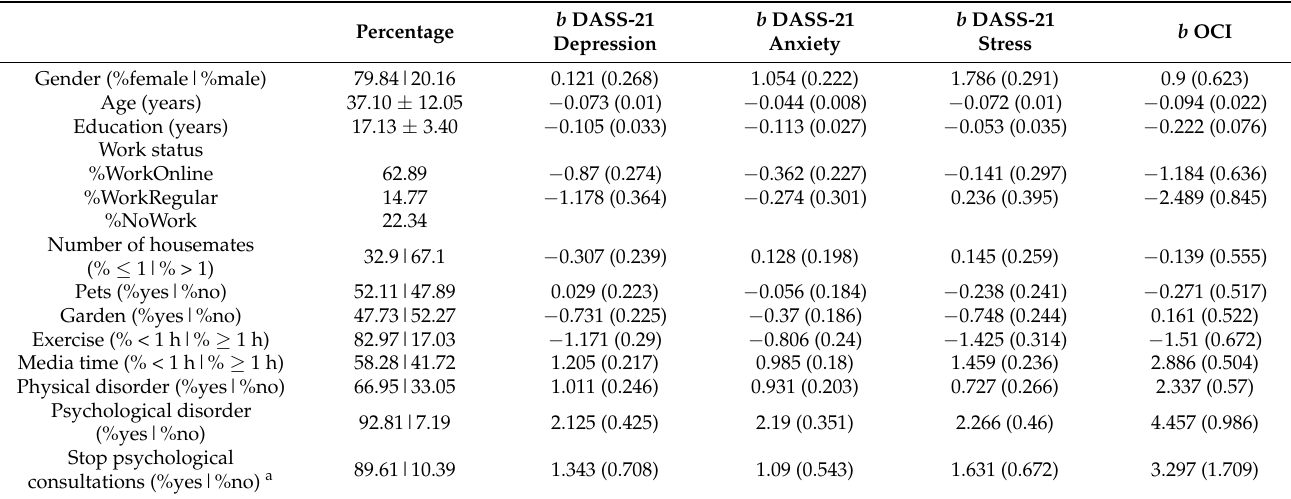
Table 1. Description of the survey demographic, social and mental health variables, and the statistical results for the linear regression